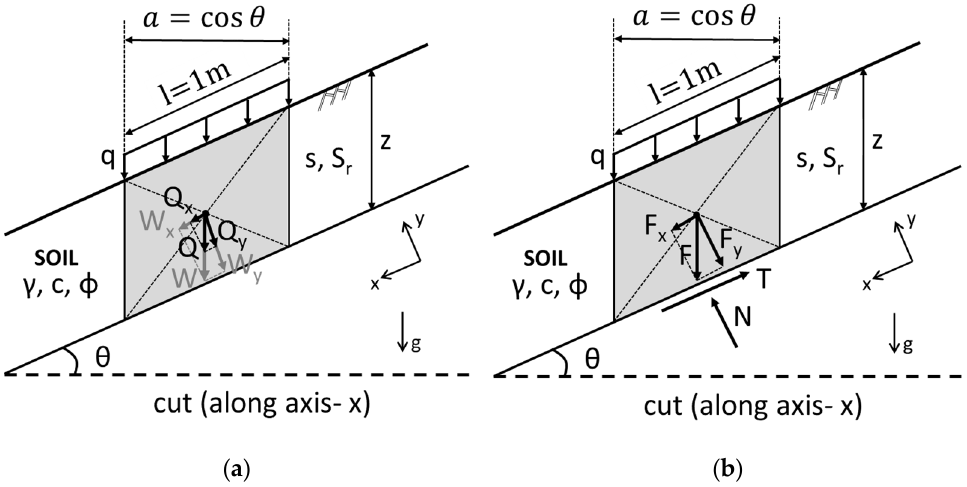
Figure 2. ( a ) Analyses of the weight of the block and of the applied surcharge; ( b ) equilibrium of the block along x axis (parallel to the failure plane) and y axis (perpendicular to the failure plane).